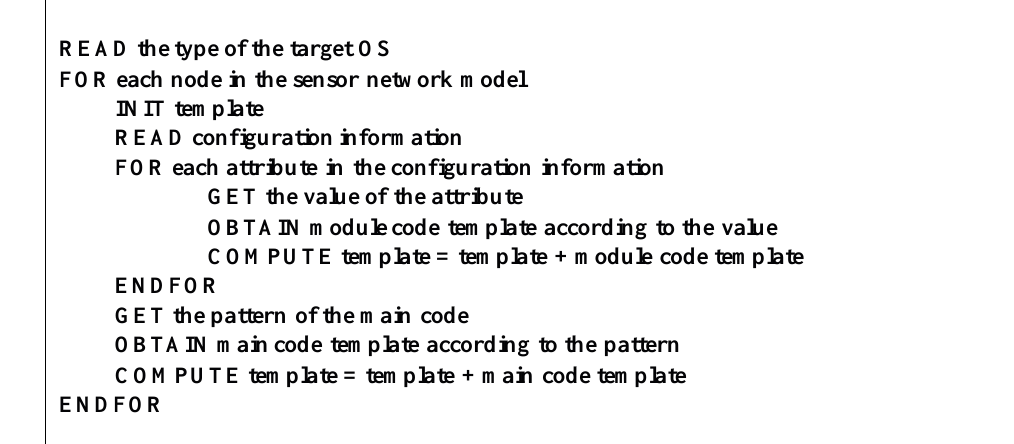
Figure 4. The algorithm for generating node